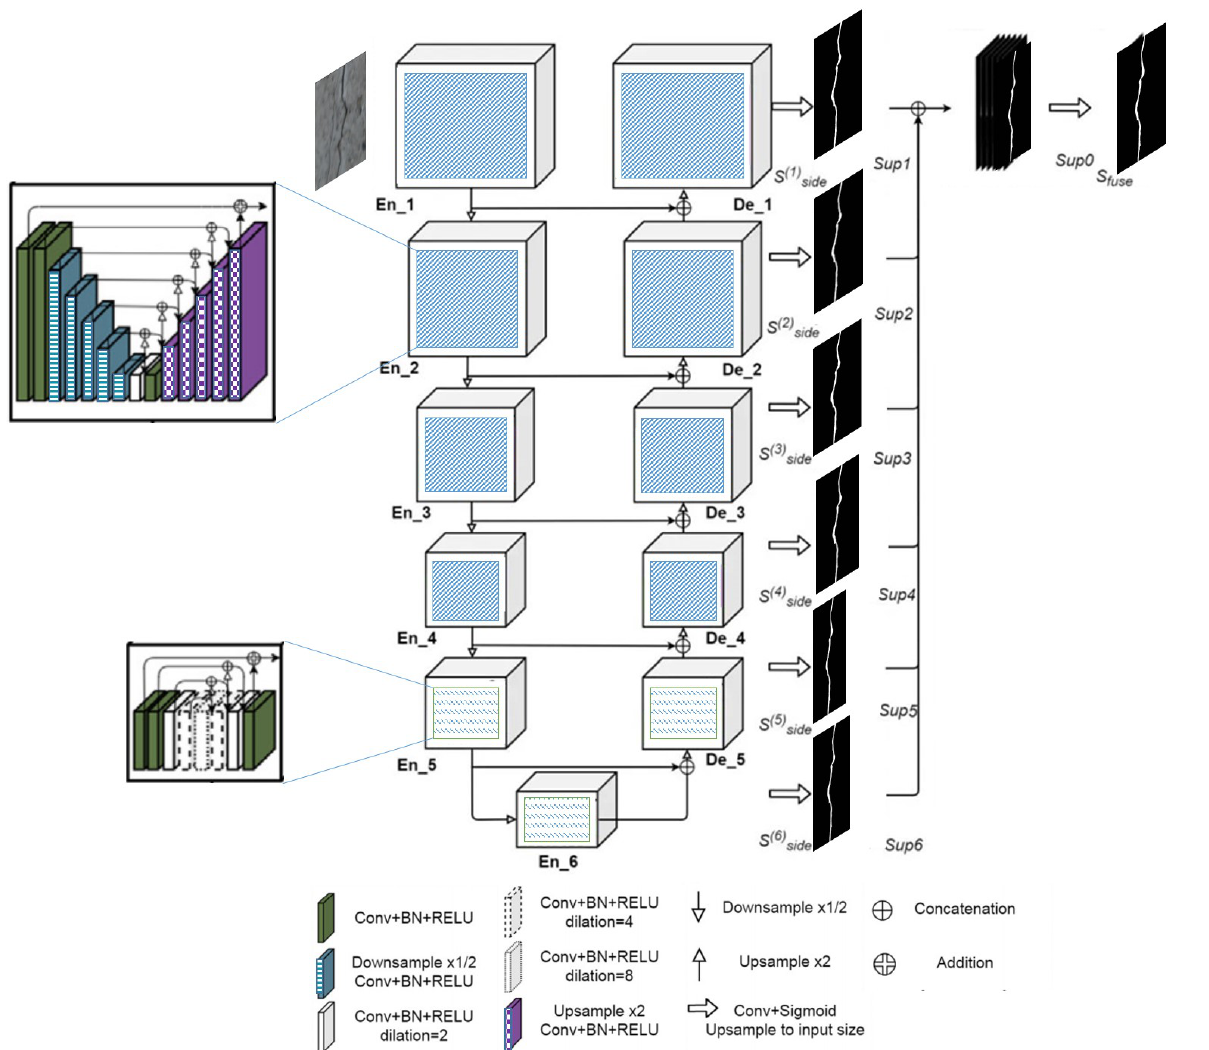
Figure 7. Architecture of U 2